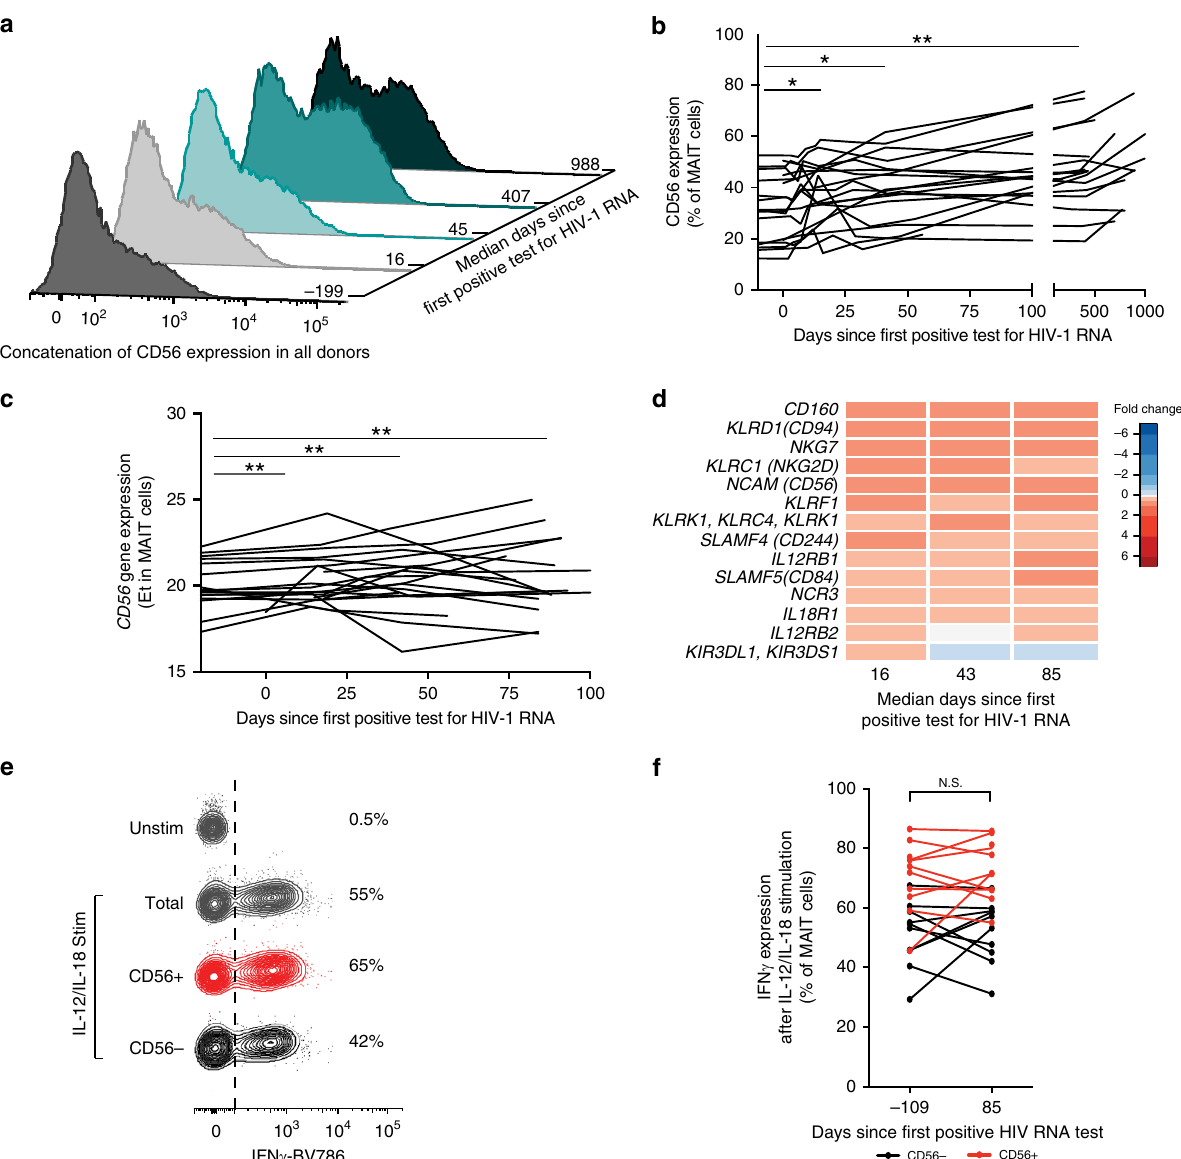
Fig. 5 MAIT cells display increased innate-like properties in acute HIV infection. a Flow cytometry was performed on PBMC from individuals in the acute capture cohort to investigate changes in CD56 expression within MAIT cells, and concatenation of all individuals examined are shown over time in acute HIV-1 infection ( n = 19). b CD56 expression in MAIT cells is displayed longitudinally at the protein level measured by fl ow cytometry, and c , at the gene expression level as measured by targeted transcriptomics (Et = #of qPCR cycles – Ct) ( n = 19). d The fold change compared to pre-infection of innate- like genes after targeted transcriptomics of bulk sorted MAIT cells at three post-infection time points in acute infection ( n = 20). e Example fl ow cytometry staining of IFN γ production in CD56 − or CD56 + MAIT cells from a pre-infection time point from one donor in the acute capture cohort after stimulation of PBMC with IL-12 and IL-18 ( n = 10). f IFN γ production in CD56 + and CD56 − MAIT cells after stimulation of PBMC with IL-12 and IL-18 at one pre- infection and one post-infection time point ( n = 10). * p ≤ 0.05, ** p ≤ 0.01. In b and c , statistical analysis was performed using the nonparametric Friedman test with the Dunn ’ s multiple comparison test; in f , using Wilcoxon Signed Rank test. PBMC, Peripheral blood mononuclear cells. MAIT cells are identi fi ed as CD161 + + V α 7.2 + cells within CD3 + CD14-CD19- live lymphocytes. Post-infection time point corresponds with early chronic HIV infection (85 days since fi rst positive test for HIV-1 RNA). The source data underlying d are provided as a Source Data fi Transiently elevated MAIT cell function precedes decline . We production of cytokines in response to bacterial stimulation were rather stable during the fi rst three time points evaluated, and next investigated MAIT cell functionality in response to bacterial showed a trend towards decline at the fi nal time point corre- or mitogen stimulus. MAIT cell responses in PBMC pulsed with sponding to early chronic HIV-1 infection (Fig. 6b). This pattern E. coli , or in response to PMA/Ionomycin, were detected by was also observed in PMA/ionomycin stimulation, with reduced intracellular cytokine expression as previously described 45 (Fig. 6a). Compared to pre-infection, MAIT cell expression of TNF expression at the fi nal time point tested ( p = 0.036; Fried- single functions did not change in response to E. coli , as ten- man test with the Dunn ’ s multiple comparison test) (Fig. 6c). dencies towards increased expression of GrzB at the time of viral Interestingly, determination of the total functionality in load set-point did not reach signi fi cance (Fig. 6b). MAIT cell MAIT cells in response to E. coli , calculated as the percentage of